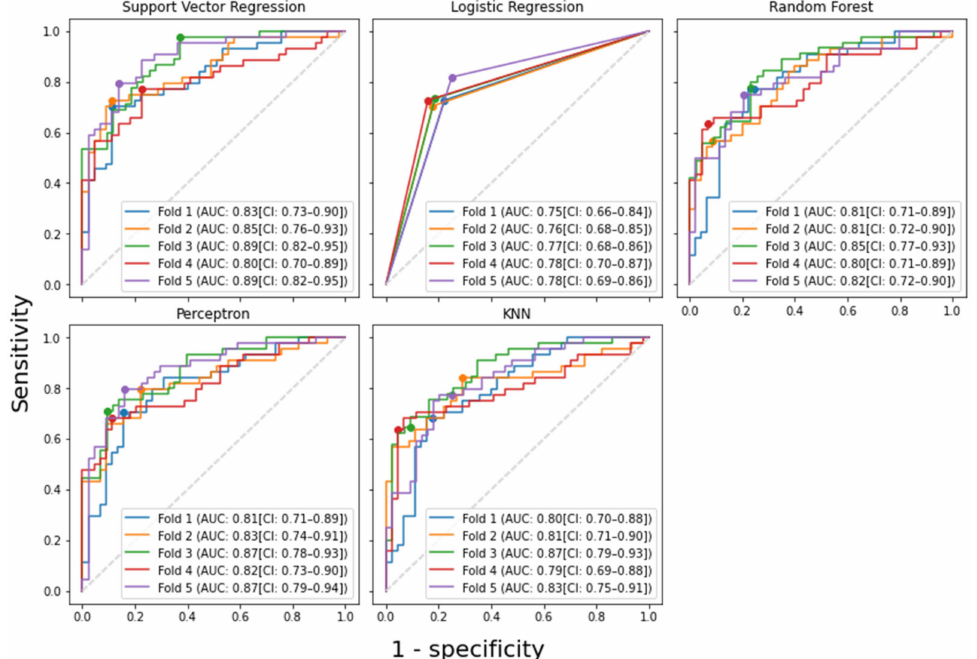
Figure 4. The receiver operator characteristic (ROC) curves of various machine learning models in discriminating stage T1 nasopharyngeal carcinoma (NPC) from benign hyperplasia in fivefold cross validation using the features selected by the proposed-RENT. The 95% confidence interval (CI) of each ROC curve was computed by bootstrapping the data 1000 times. As logistic regression resulted in a binary output of either 0 (for benign hyperplasia) or 1 (for NPC), the ROC curve has only three points in each fold. The dots on the graphs correspond to where the maximum Youden index was achieved. Support vector regression obtained the highest mean AUC (0.850) among the five tested models. k NN = k -nearest neighbors, AUC = area under the ROC curve, CI = 95% confidence